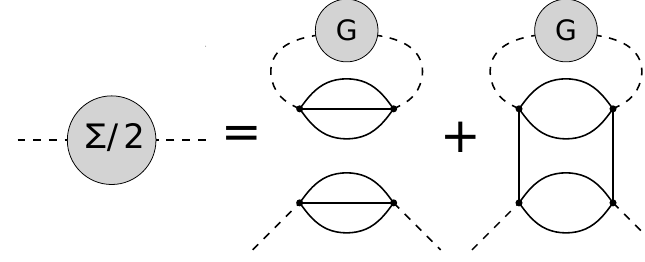
Figure 2 . Schwinger-Dyson equation at large N for the